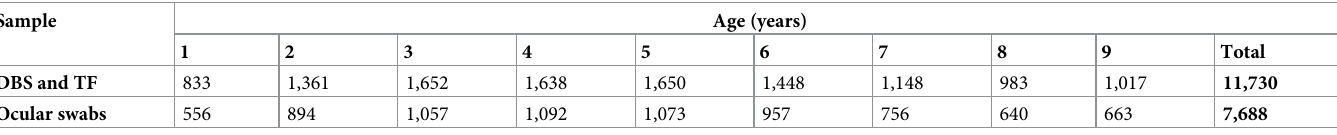
Table 2. Number of samples analysed by age. Sample